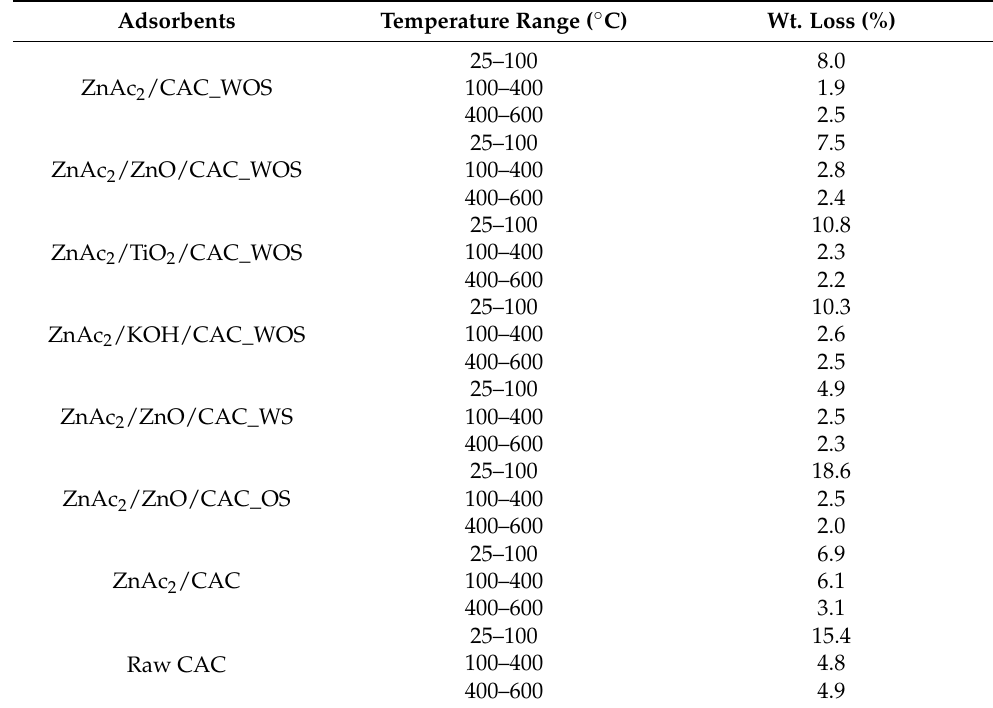
Figure 8. TGA profile for CS/CAC adsorbents. Table 6. Thermal analysis of CS/CAC